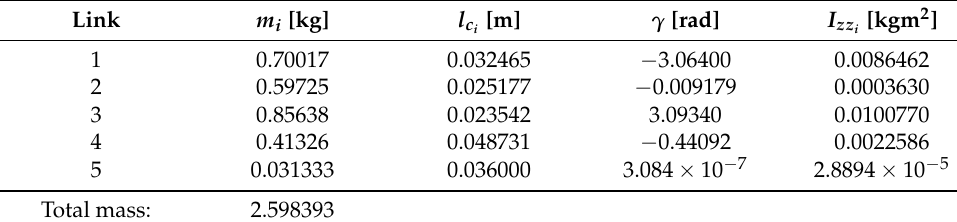
Table 5. Dynamic parameters of the